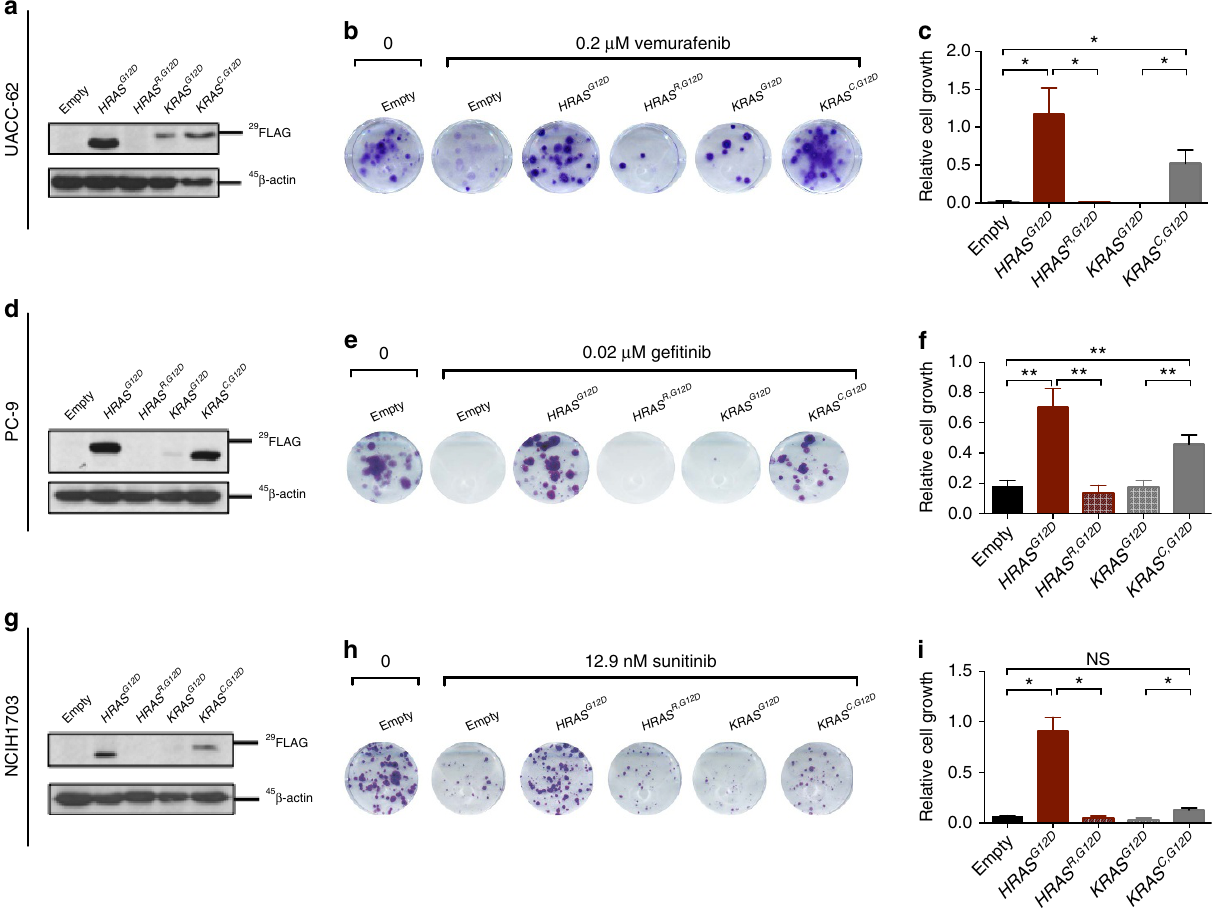
Figure 2 | Codon bias underlies the differential resistance conferred by oncogenic HRAS versus KRAS. ( a , d , g ) Immunoblot analysis with anti-FLAG and anti- b -actin in extracts from indicated cell lines stably transduced with a vector encoding the indicated transgene (or no transgene, empty). All HRAS and KRAS constructs are FLAG tagged. ( b , e , h ) Representative plate of three technical replicates of colony growth assay of various HRAS and KRAS expressing derivatives in the presence of indicated drug. ( c , f , i ) Average ± s.e.m. number of colonies in b , e , h normalized to HRAS G12D expressing cells ( n ¼ 3